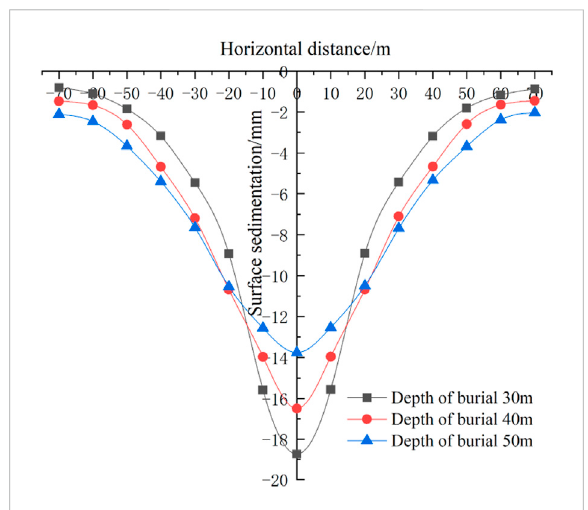
FIGURE 7 Ground surface settlement trough curves in different tunnel buried